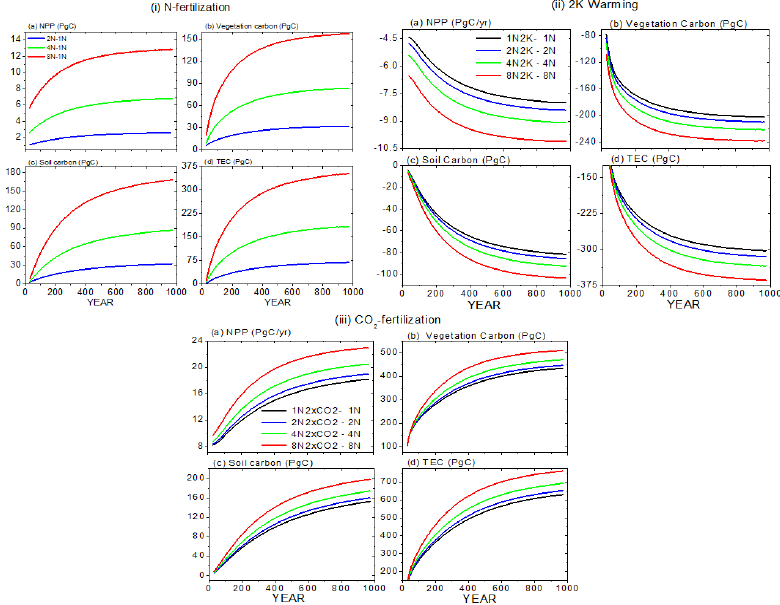
Fig. 2 CLM4 simulated global and annual mean changes in NPP, vegetation carbon, soil carbon and total ecosystem carbon for (i) N deposition, (ii) climate warming and (iii) CO 2 -fertilization at various levels of N deposition. A 57-year running average is applied to original annual mean data.